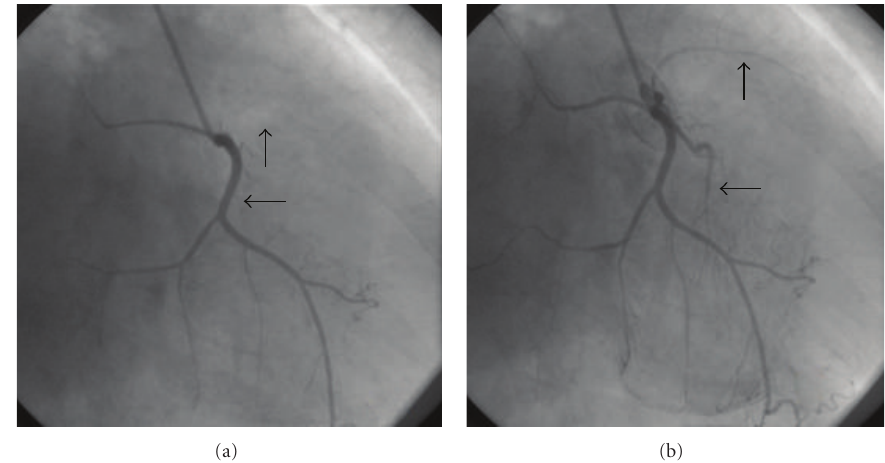
Figure 3: Systolic compression of side branches of RCA (a) is seen during systole whereas arteries are fully opened during diastole